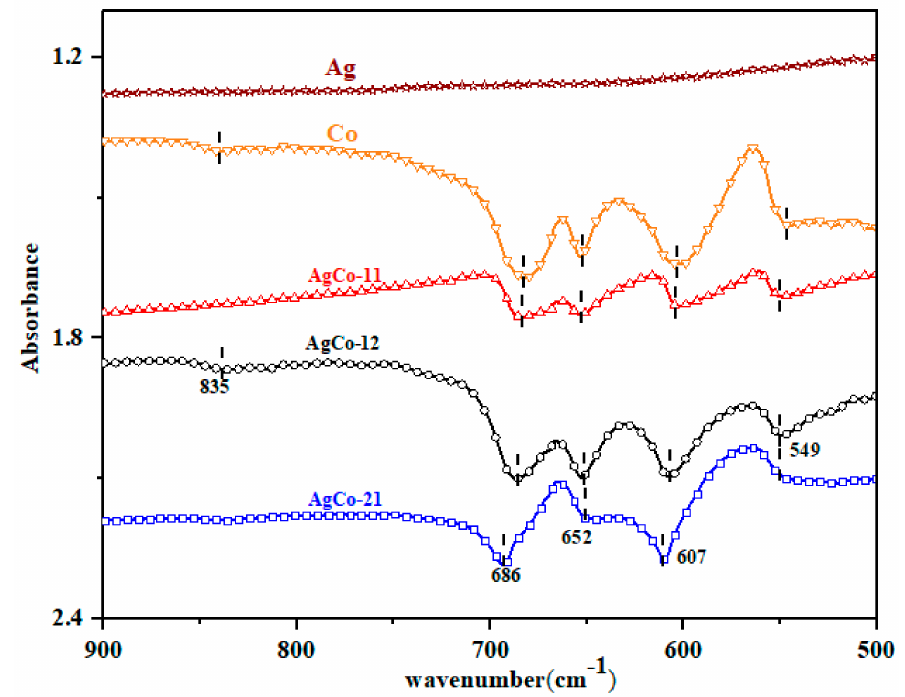
Figure 2. FTIR spectra of the as-prepared bimetals of Ag-Co and their monometals synthesized using different modes of solution combustion synthesis